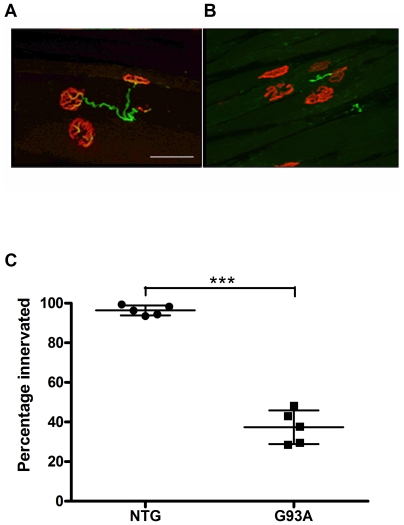
Quantification of neuromuscular junction (NMJ) innervation at 60days in SOD1G93A transgenic mice.(A, B) Immunofluorescence staining of gastrocnemius muscle with α-Bungarotoxin (red) and anti-neurofilament antibodies (green). NMJ were counted as innervated when end-plates showed overlap of neurofilament and AChR staining (A, image from a non-transgenic mouse) and denervated when endplates showed absence of neurofilament labeling (B image from a SOD1G93A transgenic mouse). Scale bar 50 µM. The percentage of α-Bungarotoxin stained end-plates showing complete and partial co-localisation of neurofilament staining versus absence of colocalisation (C) is shown for 5 non-transgenic mice (NTG) and 5 SOD1G93A transgenic mice (G93A) at 60 days of age. Average +/−standard deviation is shown (NTG 96.4+/−2.5%; G93A 37.4+/−8.5%, p<0.0001, Student's T test). Graph displays result for individual animals. Median horizontal line indicates the mean value. Upper and lower horizontal lines linked by a vertical line show SD.